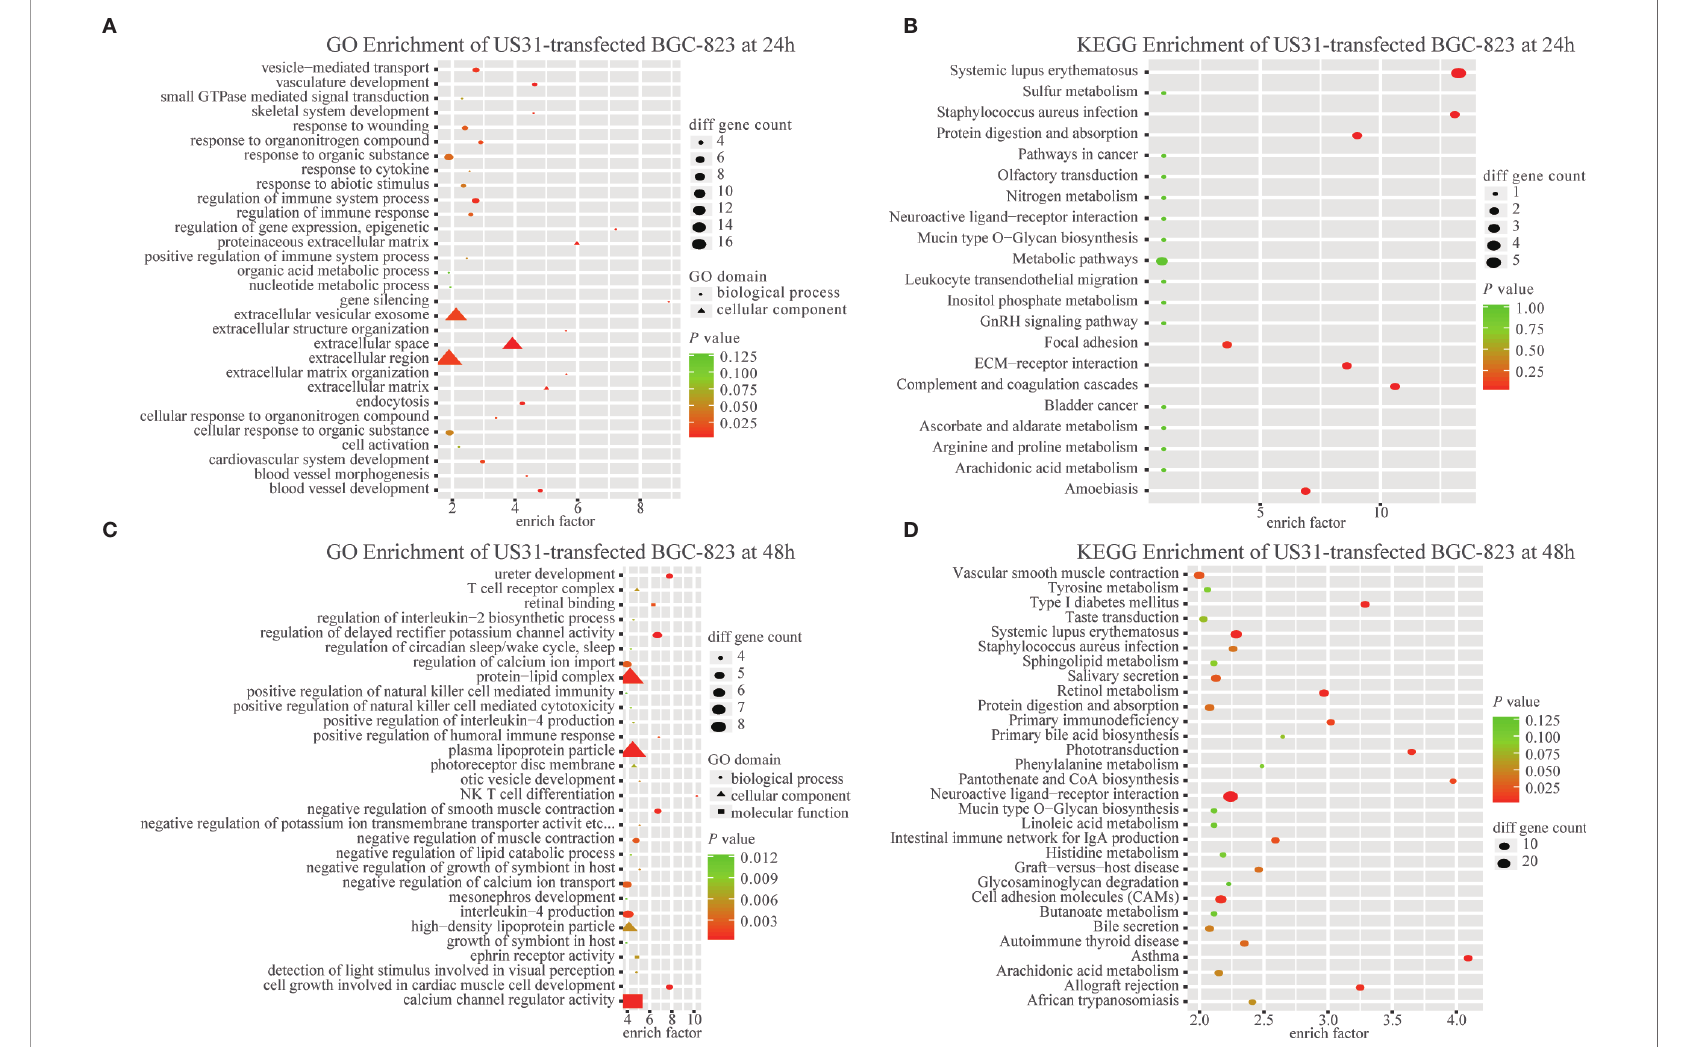
FIGURE 4 | US31 expression regulates the immune response of gastric cancer (GC) cells. (A – D) Gene Ontology and KEGG enrichment analyses of differentially expressed genes caused by overexpression of US31 in BGC-823 at 24 and 48 h,